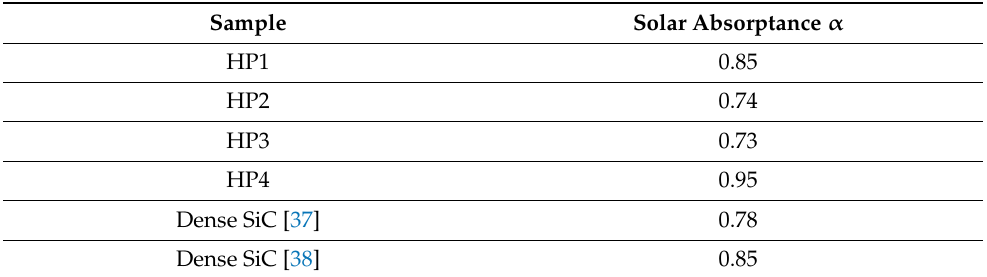
Table 2. Solar absorptance of sintered specimens, calculated from Equation (2) and of SiC pellets from